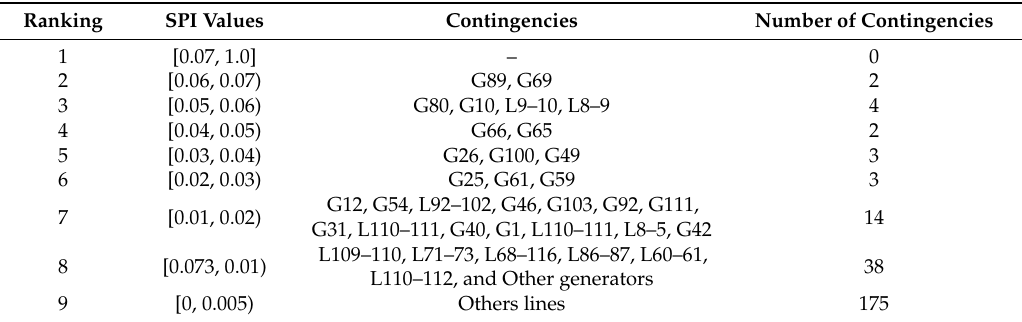
Table 4. SPI values of part